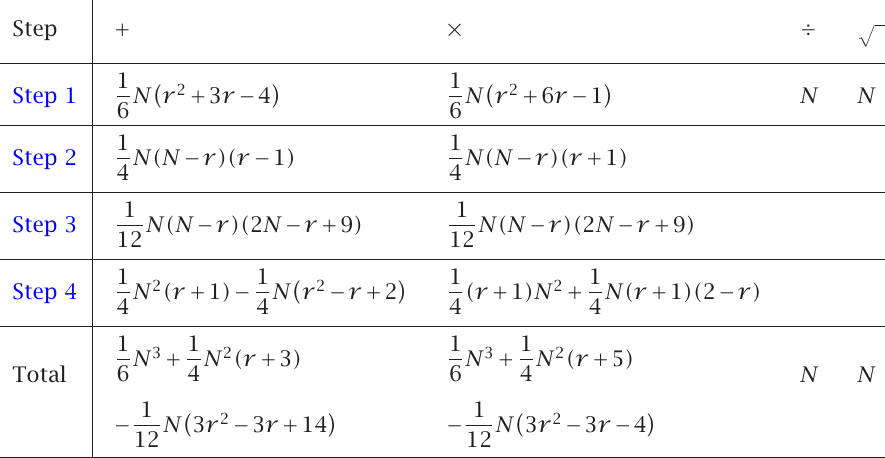
Table 3.1 . Operations counts for parallel